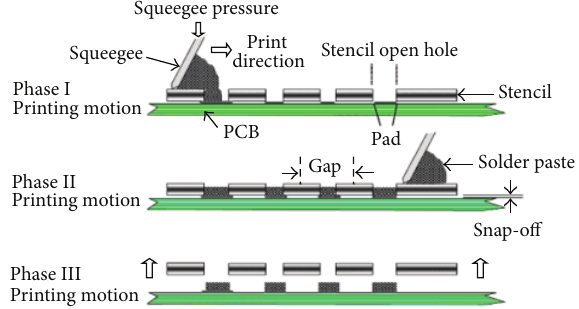
Figure 2: The solder paste printing